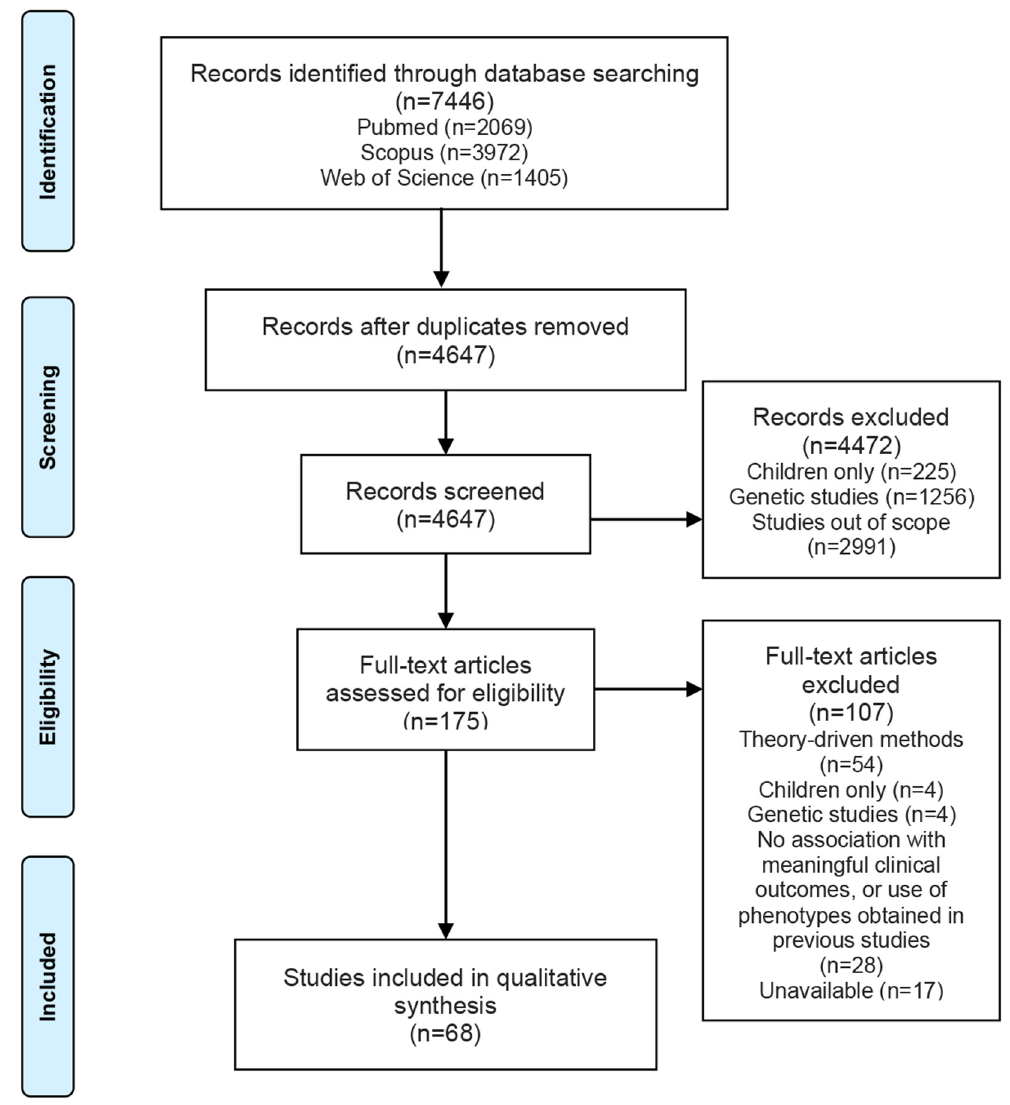
Figure 1. Preferred Reporting Items for Systematic Reviews and Meta-Analyses (PRISMA) flow diagram illustrating the studies’ selection process.